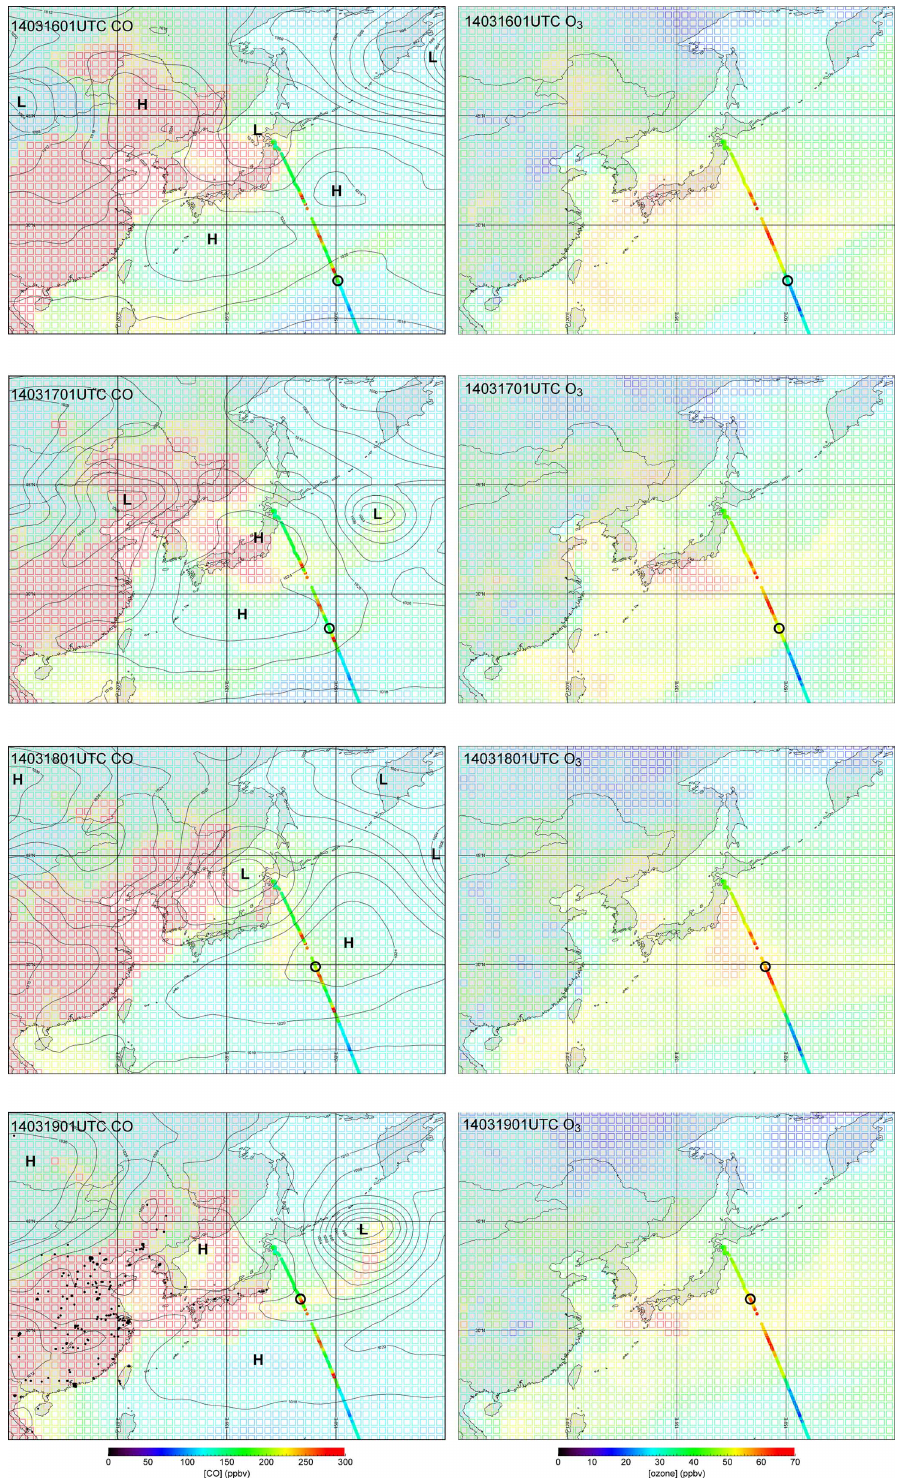
Figure 6. Temporal evolution of surface CO and O 3 distribution from TCR-2 (colored open squares) and from observations on R/V Mirai (all data, position of vessel is black circle) during MR14-02 (from 16 to 19 March 2014). Black circles in the bottom-left CO panel indicate locations with high anthropogenic CO emissions